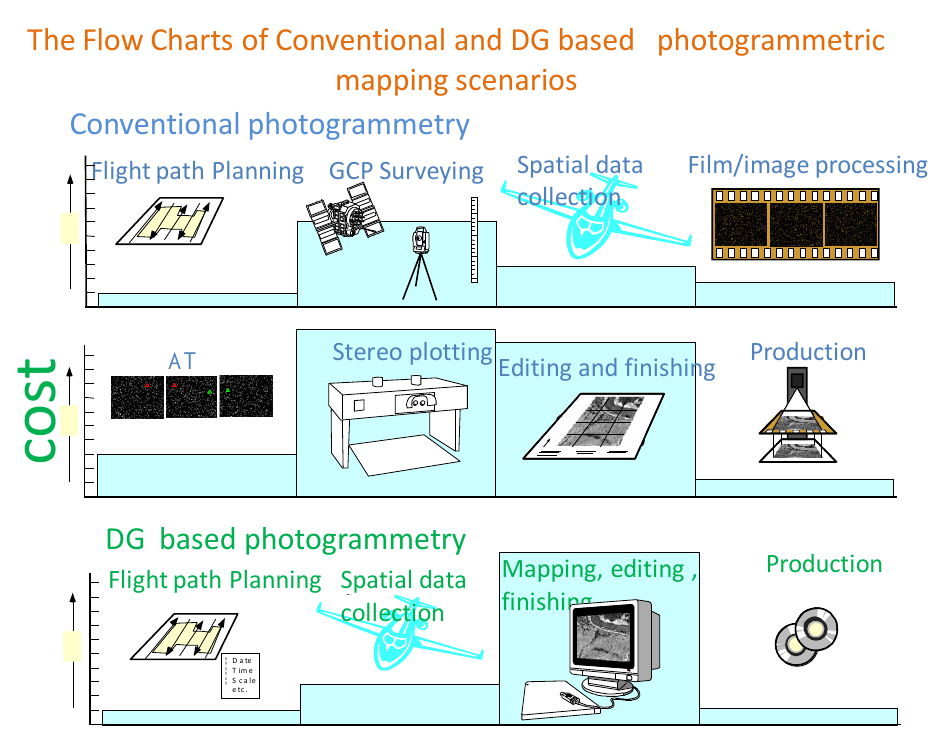
Figure 1. Procedures applied for conventional aerial photogrammetry (adopted from